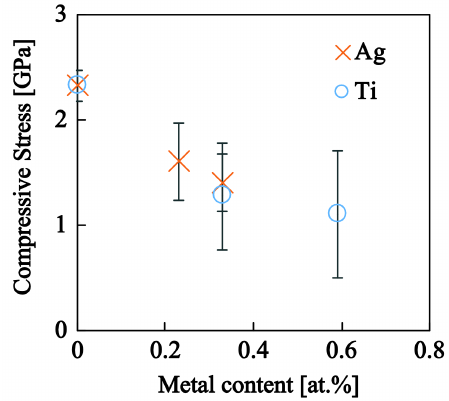
Figure 8. Residual stresses of the nanocomposite films as a function of the metal